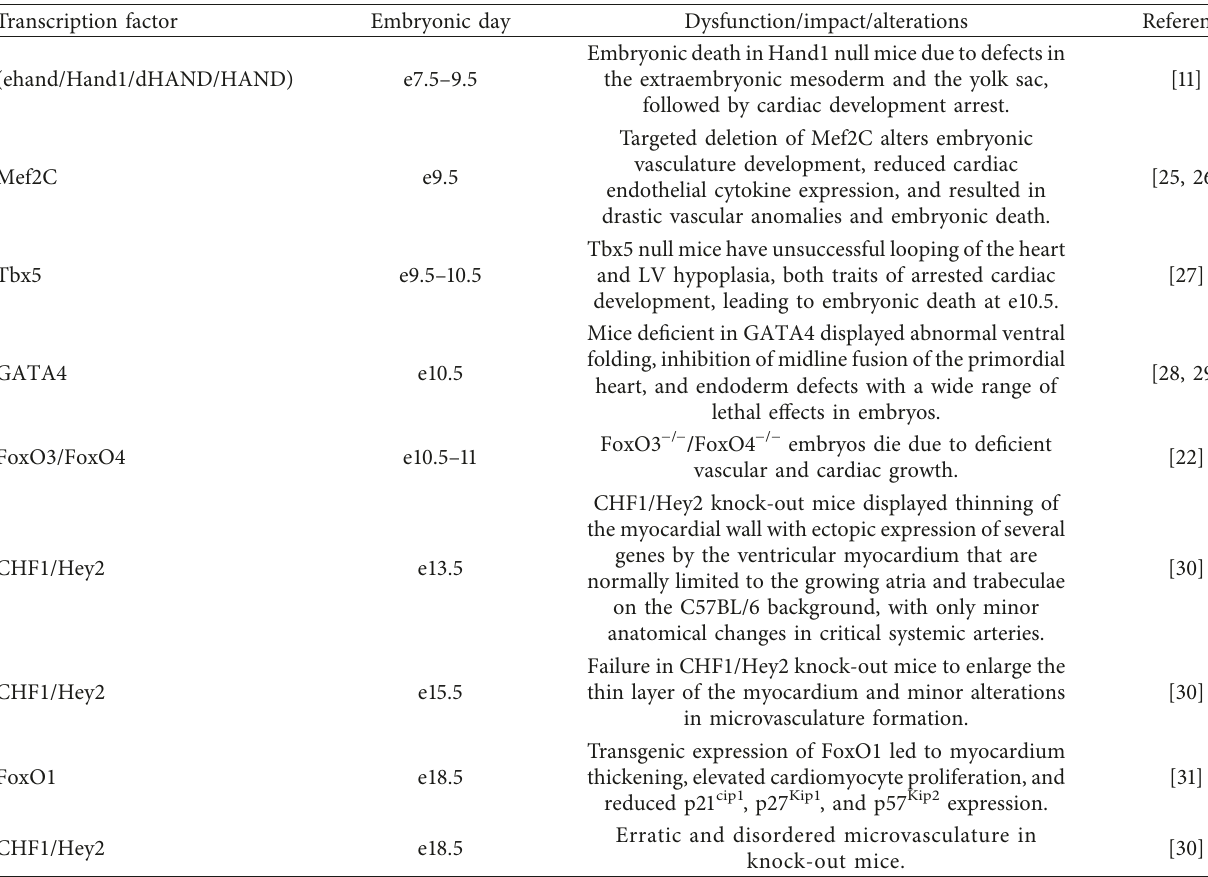
Table 1: Cardiac-specific transcription